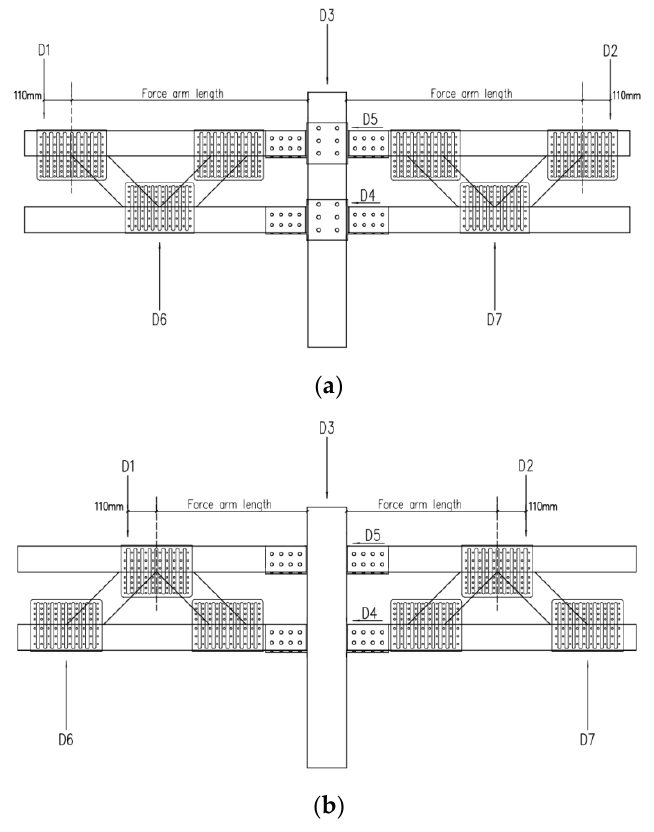
Figure 10. Positions of displacement transducers. ( a ) For specimens JU60 − 1, JU60 − 2, JU100 − 3, and JU100 − 4; ( b ) for specimens JU60 − 3, JU60 − 4, JU100 − 1, and JU100 − 2.